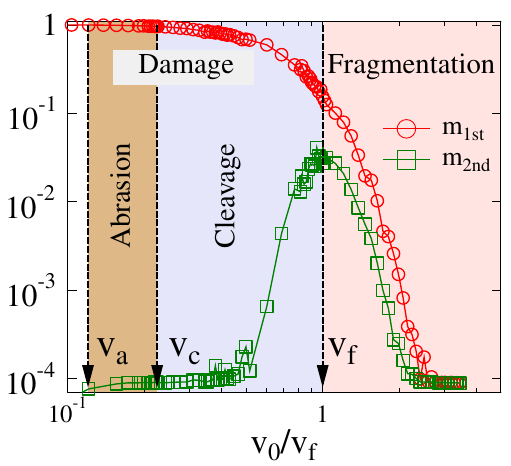
Figure 2. The three energy phases. Mass of the largest m 1 st and second largest m 2 nd fragments obtained after a single impact as function of the impact velocity v 0 . In the regime v 0 < v a of low velocities no cracking occurs and the impactor elastically rebounds from the wall. In the abrasion phase v a < v 0 < v c small fragments are removed from the body by chipping. To achieve complete breakup in a single impact, v 0 has to exceed the critical fragmentation velocity v f . In the intermediate velocity range v c < v 0 < v f of cleavage, cracks penetrate deeper inside splitting larger pieces from the body. The critical velocity v c of cleavage is the threshold velocity above which the asymptotic remaining mass tends to zero in repeated collisions. Horizontal axis shows on logarithmic scale the impact velocity v 0 normalized by critical fragmentation velocity v f . For the model solid we found the (non-dimensional) ratio of threshold velocities to be v a / v f = 0.124 . and v c / v f = 0.224